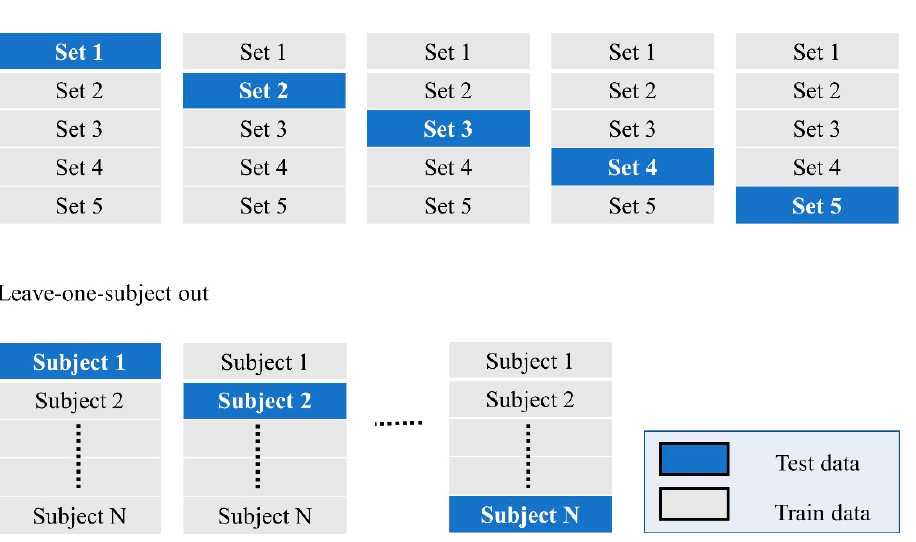
Figure 12. Cross-validation setting for the tested models.